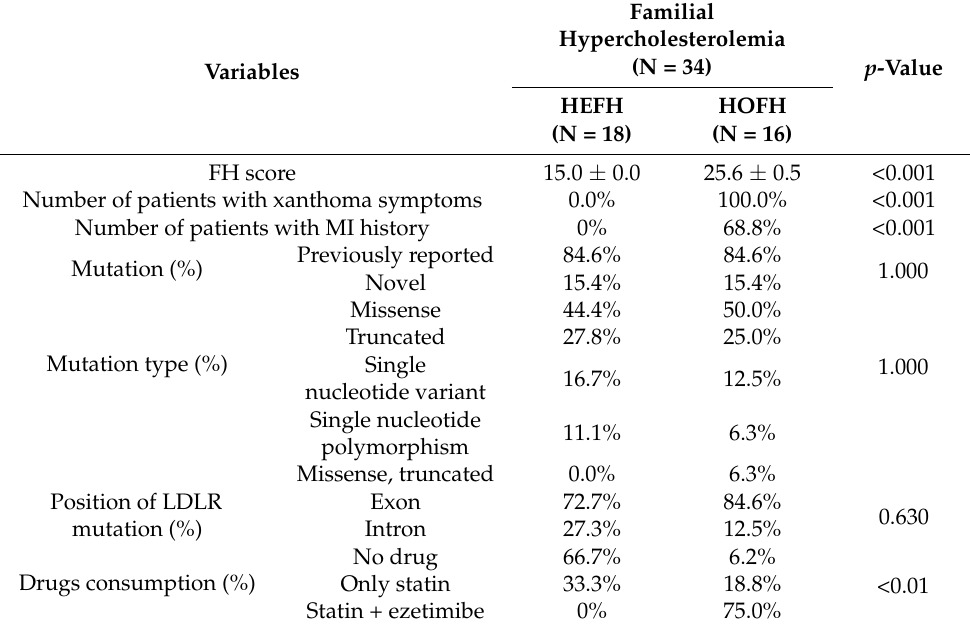
Table 2. Clinical characteristics of the FH